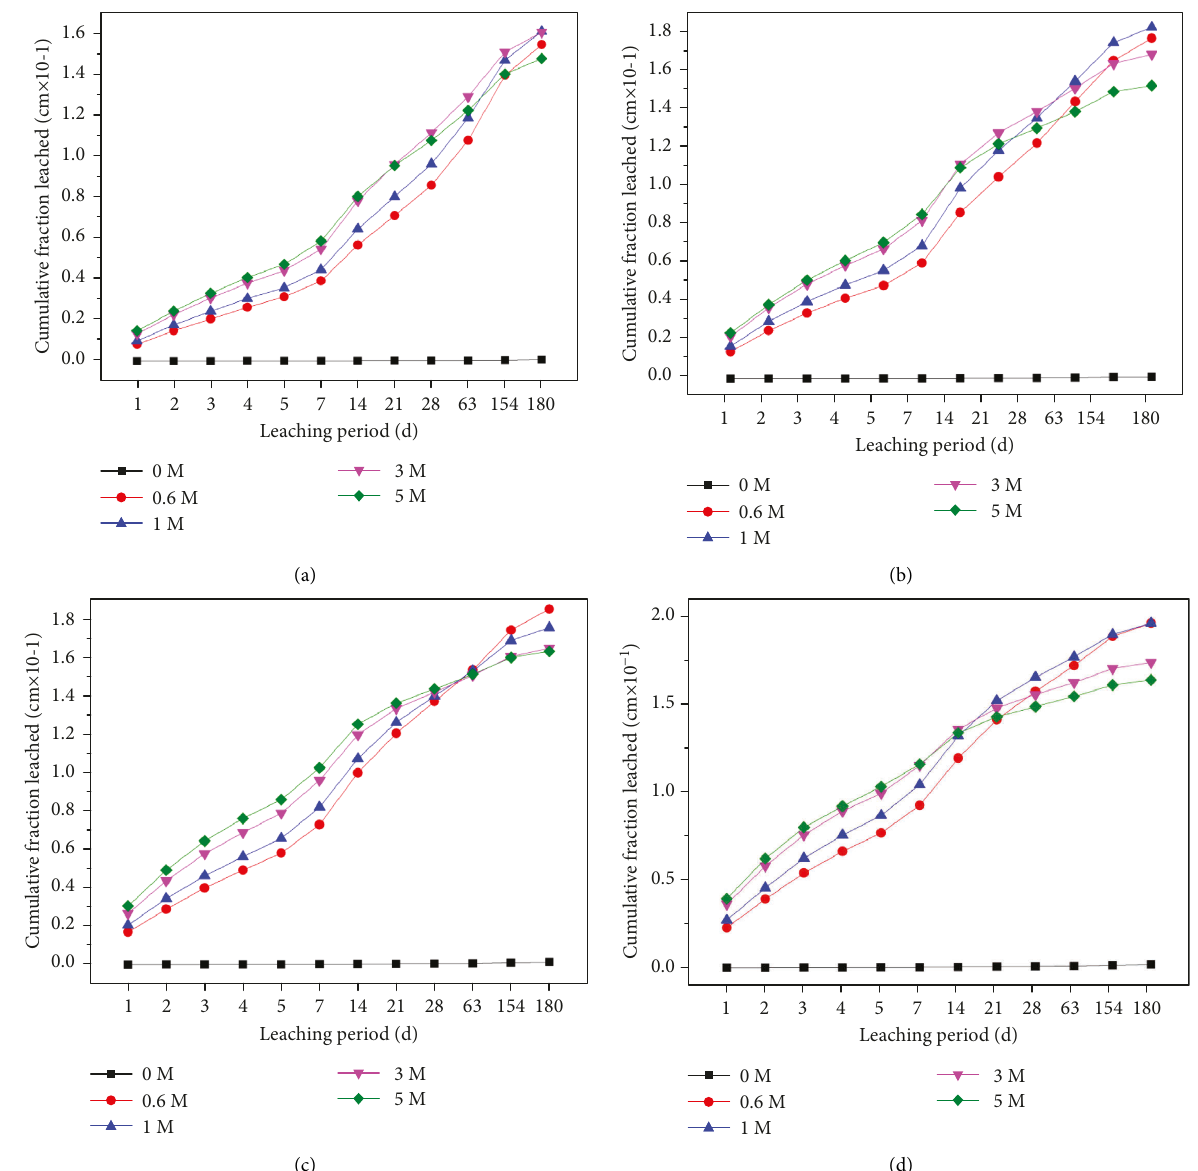
Figure 6: CFL of Ca 2+ in fly ash/cement waste forms under simultaneous effect: (a) 20 ° C; (b) 40 ° C; (c) 60 ° C; (d) 80 °